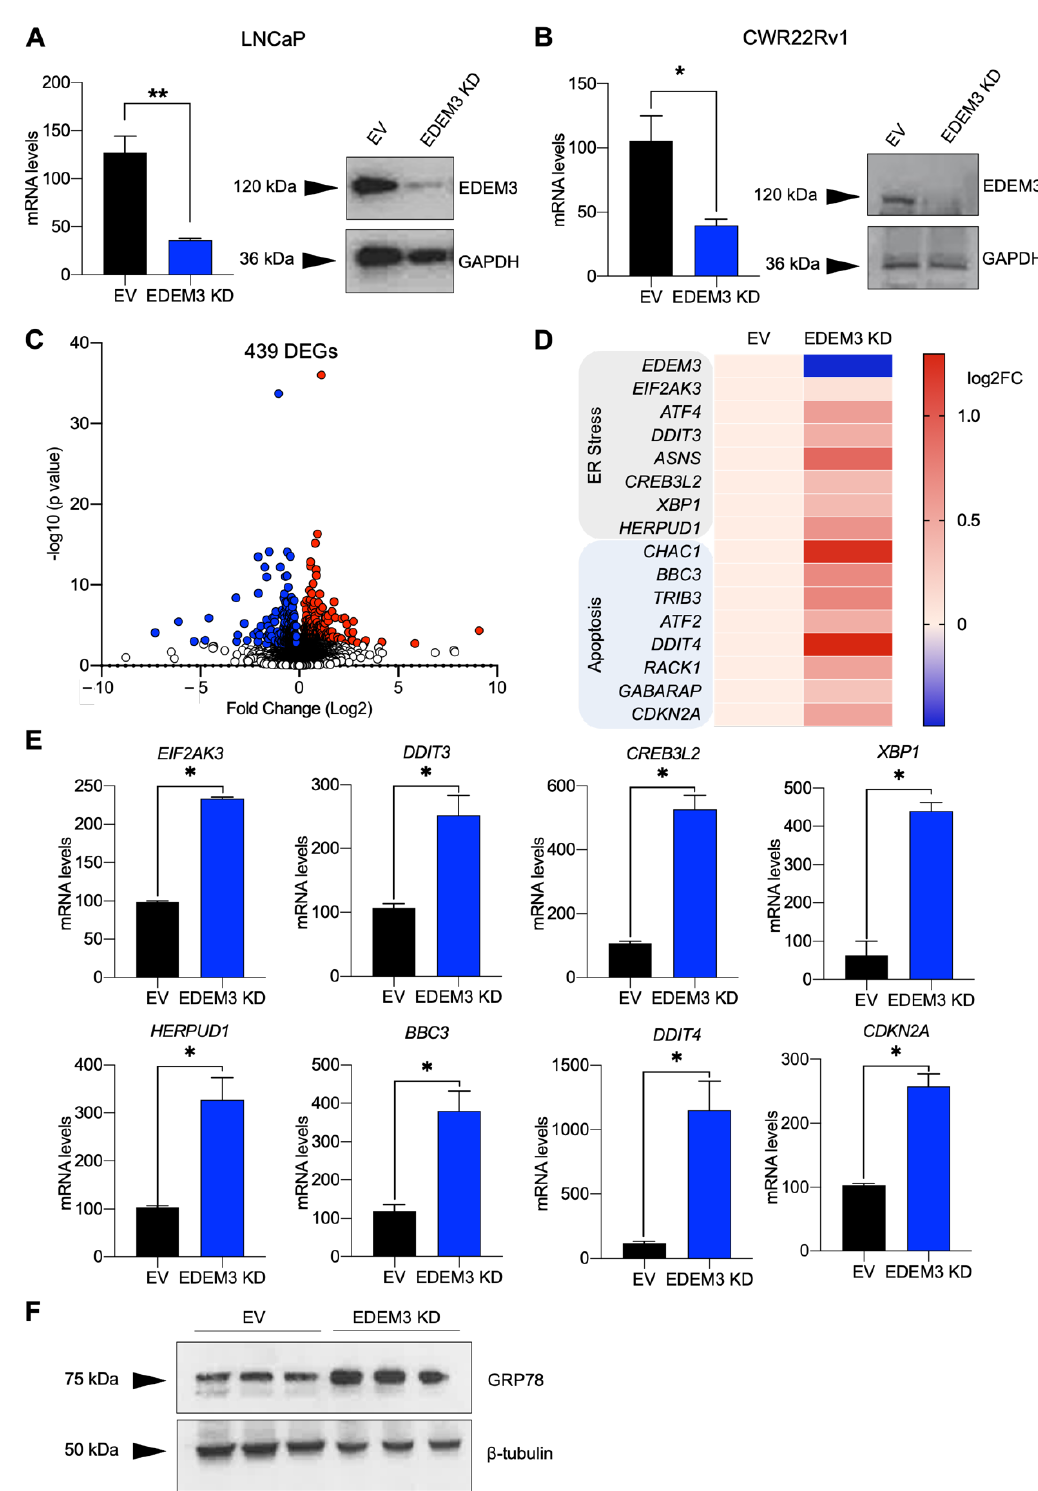
Figure 2. Depletion of EDEM3 from prostate cancer cells increases expression of ER stress and apoptosis-associated genes. ( A , B ) mRNA and protein levels of EDEM3 in LNCaP and CWR22Rv1 cells following shRNA-mediated EDEM3 gene knockdown compared with empty vector control. mRNA levels shown as mean ± s.e.m. Protein levels detected by Western blotting. GAPDH was used as a loading control. ( C ) Volcano plot showing transcriptomic analysis of CWR22Rv1 cells following EDEM3 gene knockdown. Significantly downregulated genes are shown in blue and significantly upregulated genes are shown in red. Significance was determined using an adjusted p value. * p < 0.05, ** p < 0.01. ( D ) Heatmap showing the log fold change in gene expression levels of ER stress and